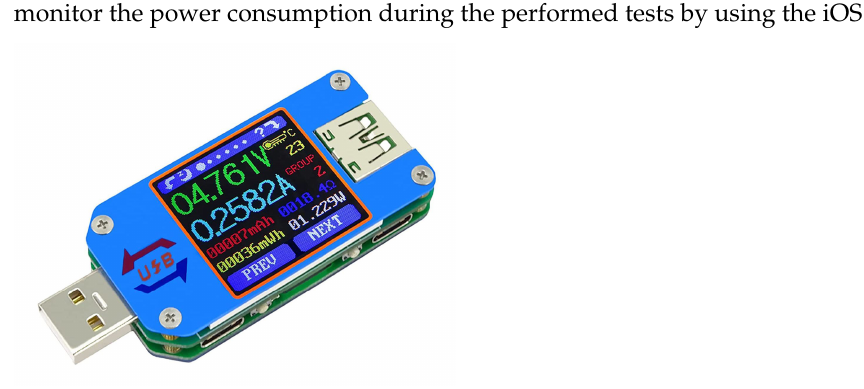
Figure 6. USB power meter tester used to estimate the power